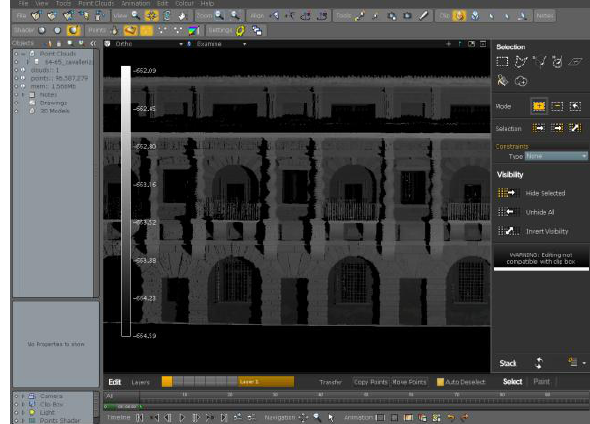
Figure 3. Software Pointools: depth map